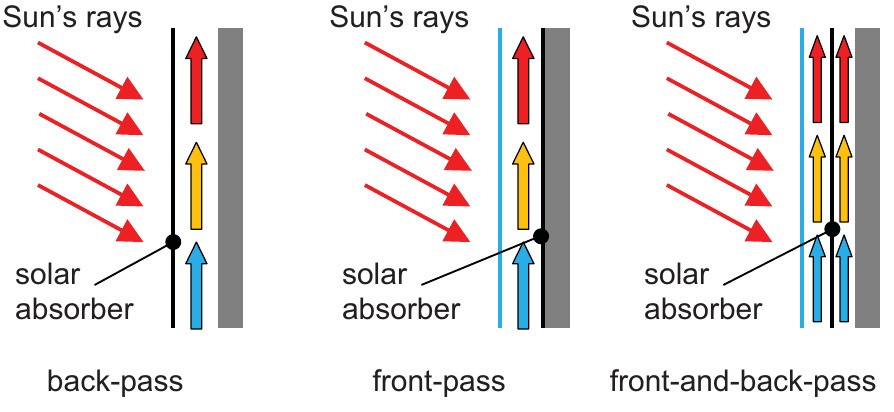
Figure: 1: Air collector